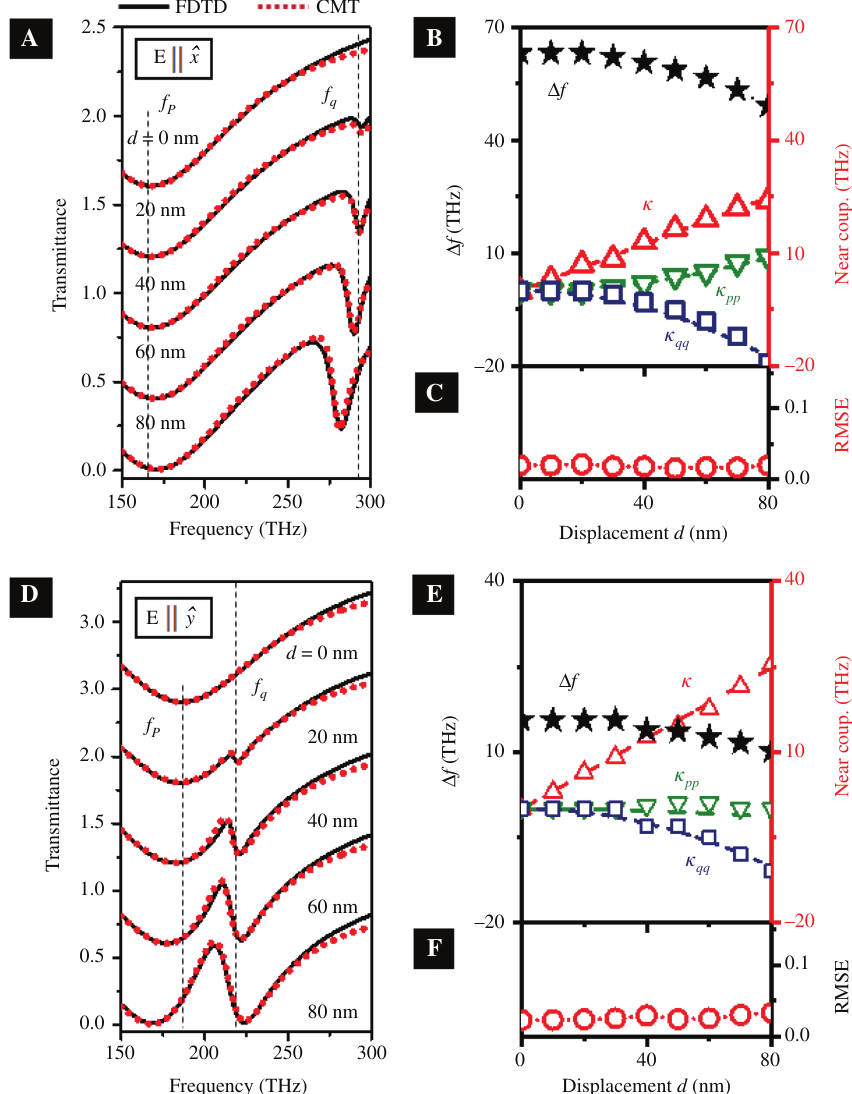
Figure 5: CMT modelling of the bright-dark coupled resonators. (A, D) FDTD-simulated (solid black curves) and CMT-fitted (red dotted curves) transmission spectra for samples with different values of d , shined by normally incident light with two different polarizations. (B, E) Retrieved CMT parameters as functions of d for two different polarizations. (C, F) RMSE of CMT spectra (red circle symbols) with (C) x -polarized and (F) y -polarized incident